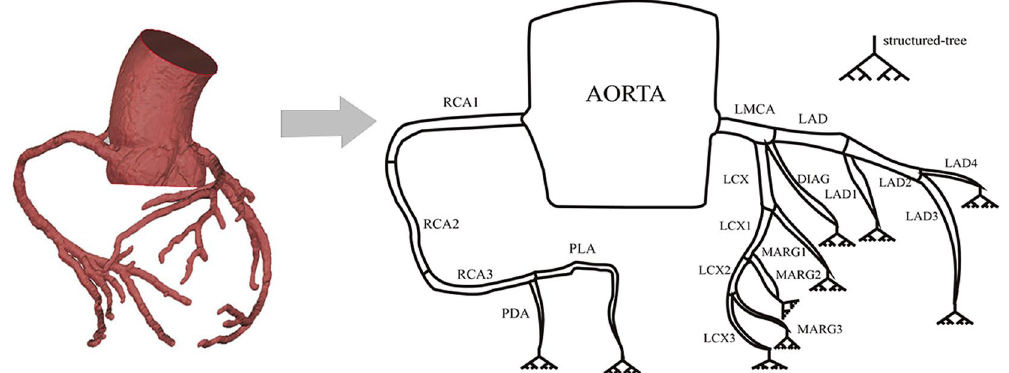
Figure 6. Reconstruction of the model, based on the CT scan (left) to the model representation of the whole coronary tree (right). The model is clinically divided into segments with names according to the CT terminology. The terminal branches are connected to a structured tree model representing the capillary bed in the